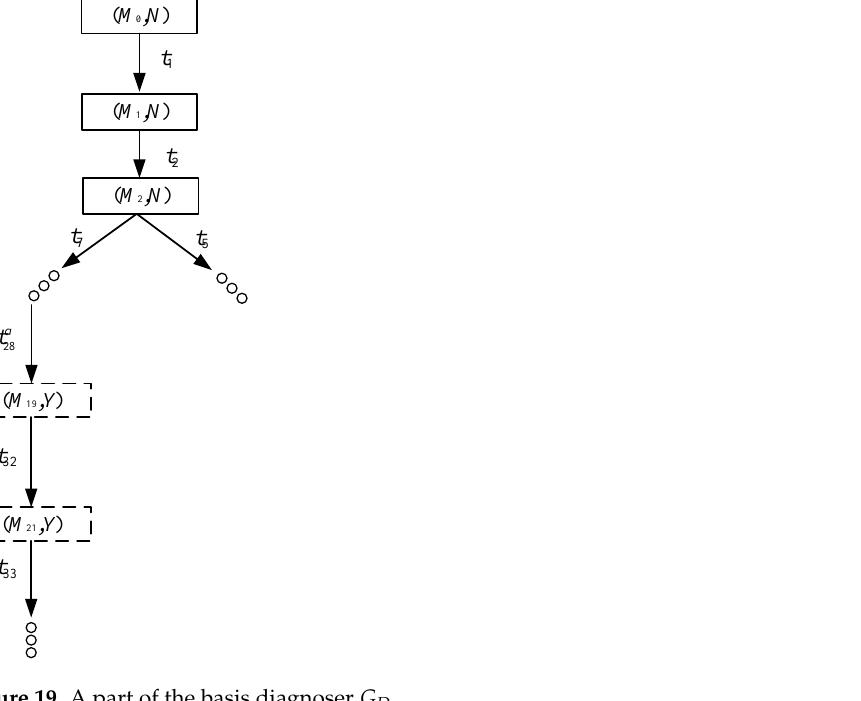
Figure 19. A part of the basis diagnoser G D